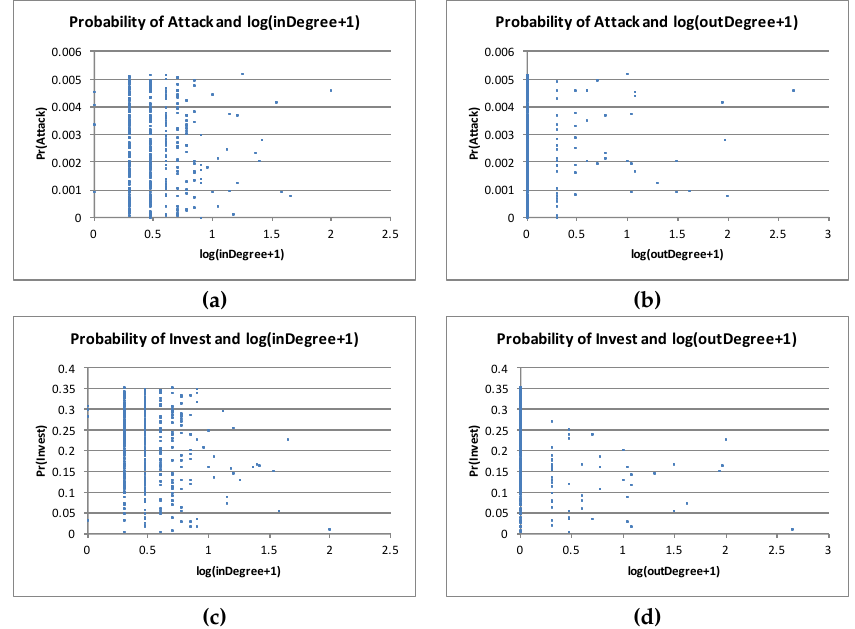
Figure 10. Attacker’s Equilibrium Strategy vs Degree of the Nodes at 0.05-MSNE. These are plots on the 402 nodes with the highest y i . The two graphs on top, ( a ) and ( b ), show the corresponding y i ( y -axis) and its indegree and outdegree in logarithmic (base 10) scale. Similarly, the two graphs at the bottom, ( c ) and ( d ), show the corresponding x i ( y -axis) and its indegree and outdegree in logarithmic (base 10) scale.